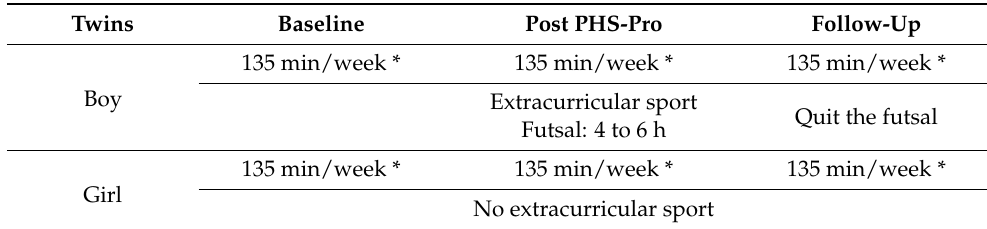
Table 2. Physical Activity time of both twin over the three